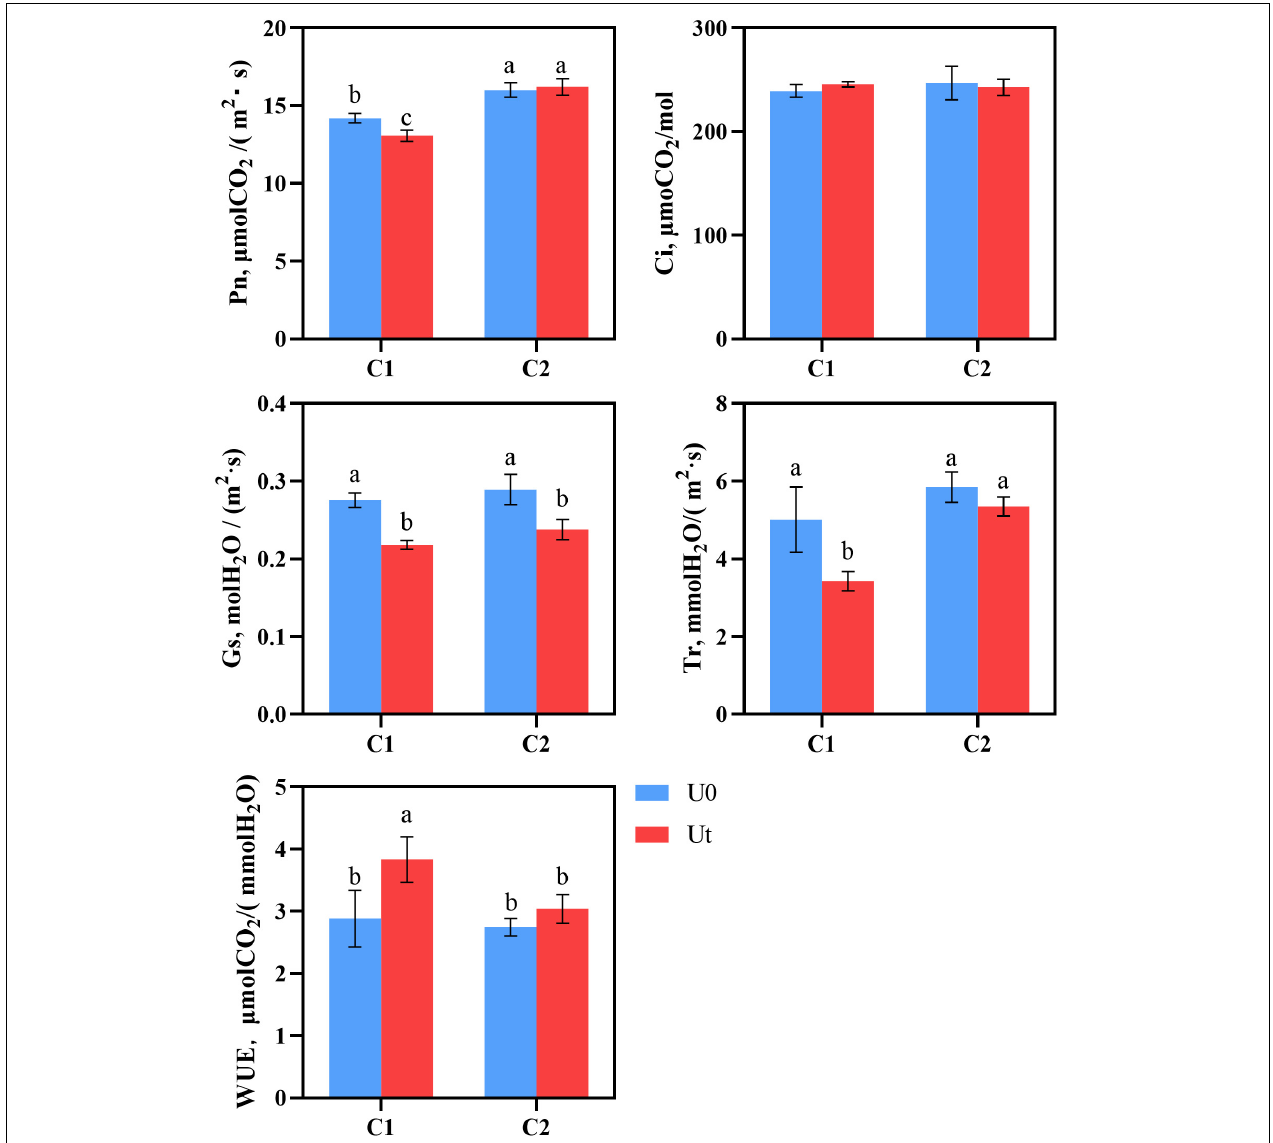
FIGURE 3 | Photosynthesis of two Angelica sinensis cultivars in response to enhanced UV-B radiation. Different letters indicated the significant difference ( P < 0.05). Error bars were represented standard deviation